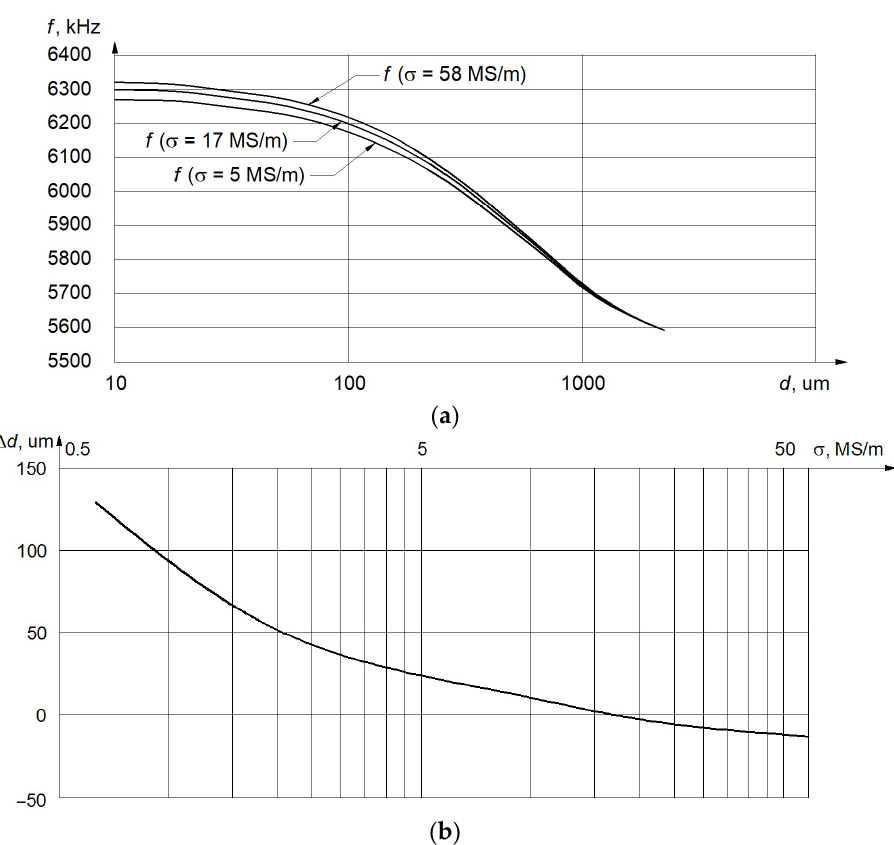
Figure 4. ( a ) Dependence f on d at σ = 5 MS/m, σ = 17 MS/m and at σ = 58 MS/m, ( b ), dependence the deviation of d on σ.